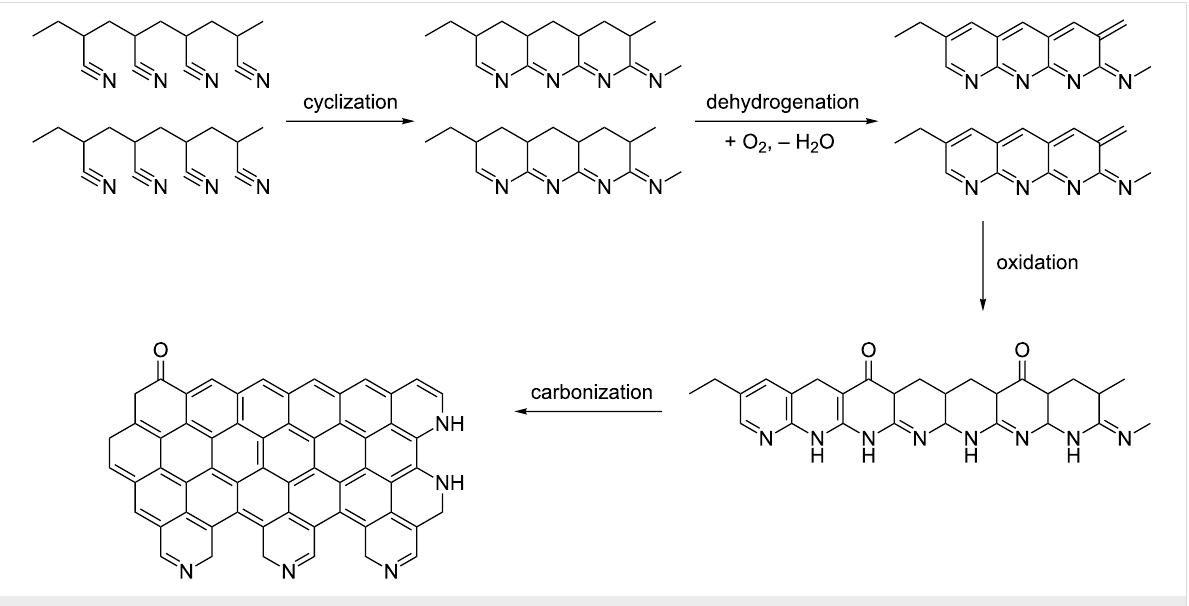
Figure 3: Schematic description of carbonization process starting from polyacrylonitrile.